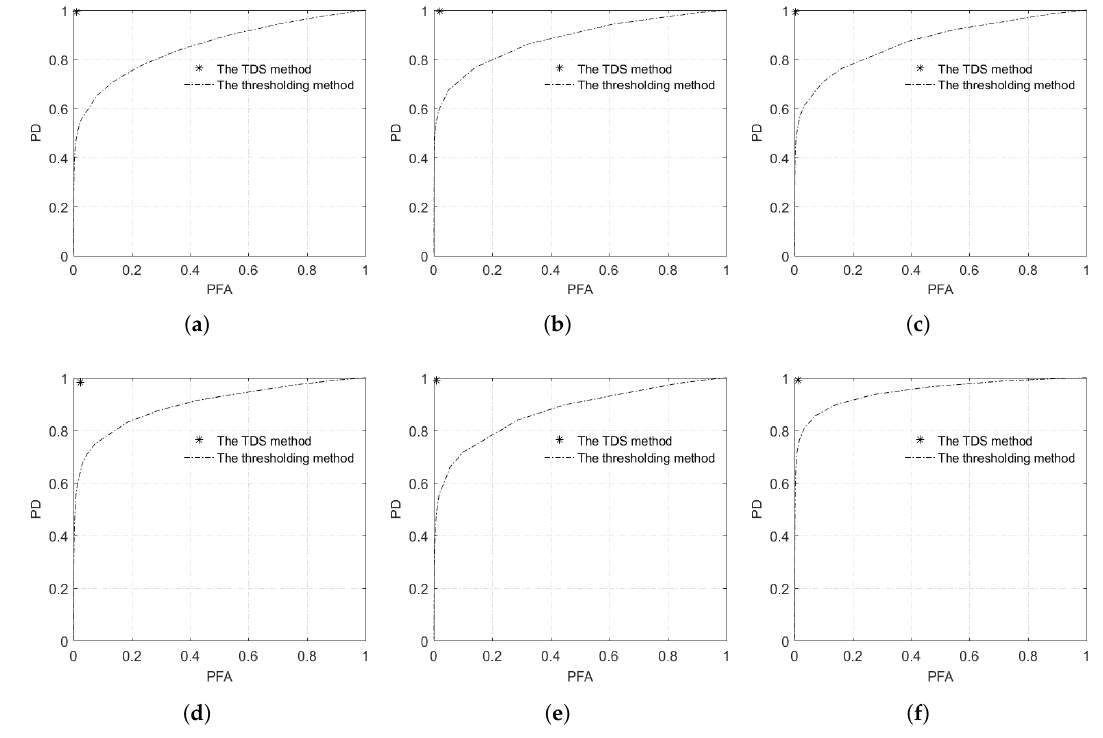
Figure 8. Receiver Operating Characteristic (ROC) curves of the TDS method and the thresholding